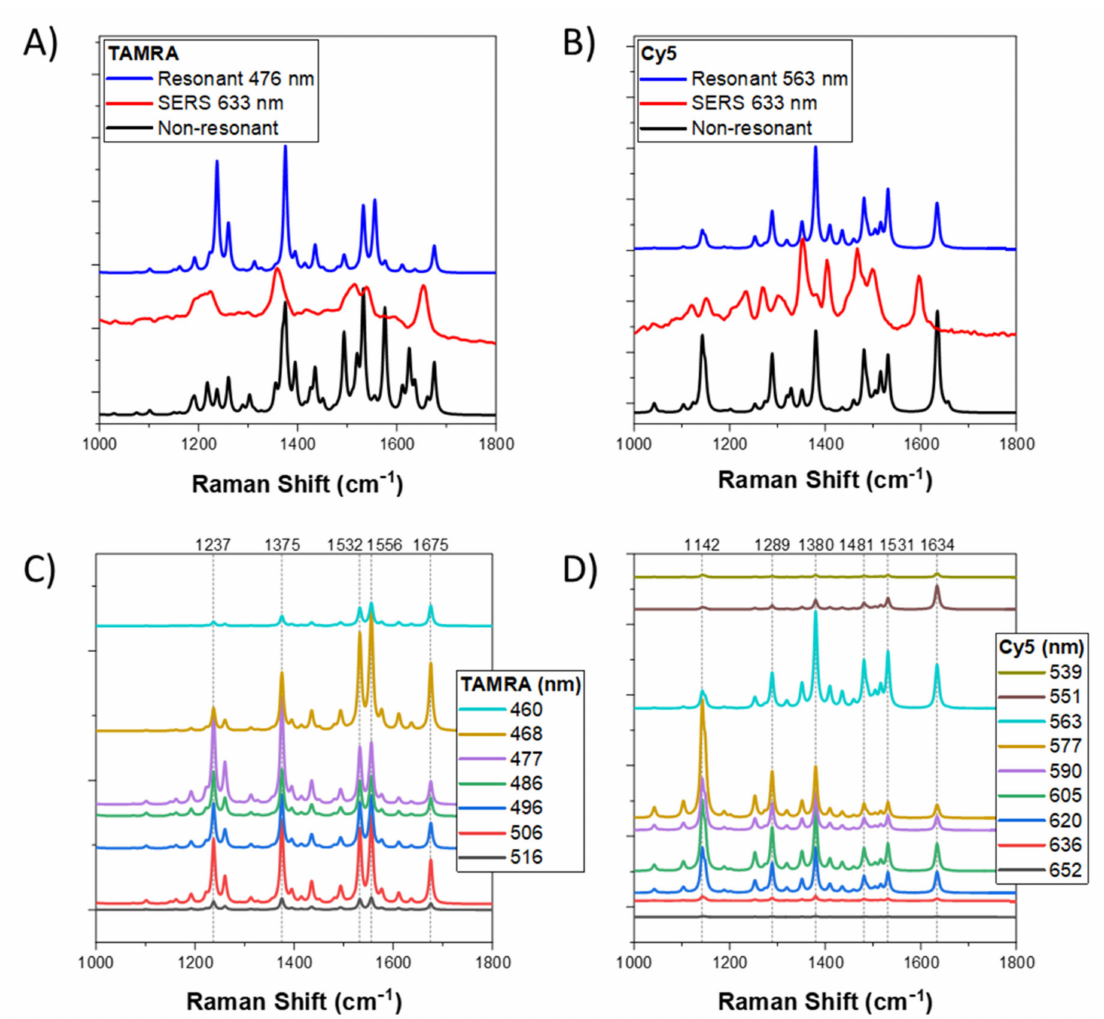
Figure 7. Comparison between the experimental SERS spectra obtained at 633 nm with the simulated non-resonant and resonant Raman spectra of ( A ) TAMRA and ( B ) Cy5 in 1000 to 1800 cm − 1 region which gives the most intense peaks experimentally. Simulated resonance Raman spectra of ( C ) TAMRA and ( D ) Cy5 using different excitation wavelengths. The excitation energies chosen here are related to the region of the spectra with the strongest resonance enhancement. All calculations were done on the B3LYP/6-311++G**+D3 level of theory, with a water environment modeled by a polar- izable continuum. Theoretical stick spectra were broadened by Lorentzians with FWHM of 8 cm − 1 (see computational methodology section for further